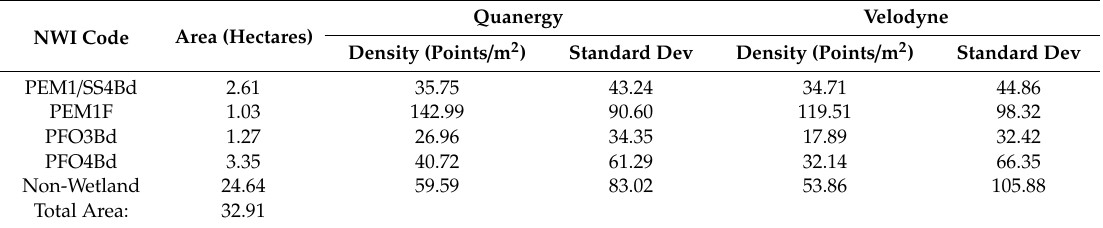
Table 8. Mean point density statistics for wetland vs. non-wetland NWI delineations for the 5 m 2 tessellation